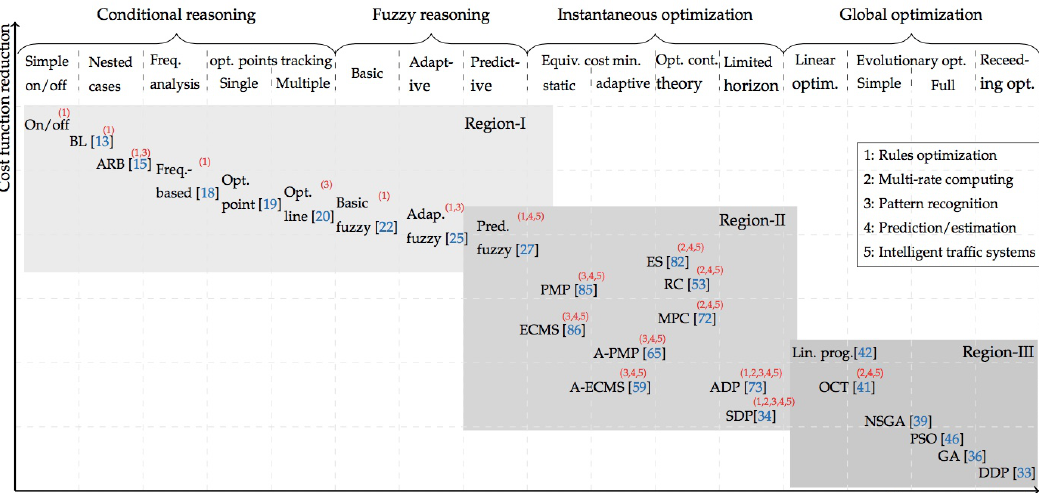
Figure 9. Comparative evaluation of different power management